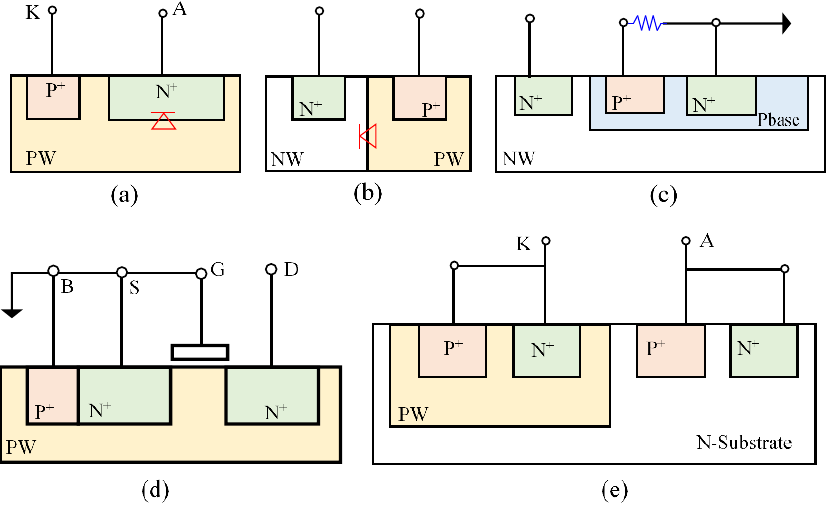
Figure 16. Traditional in-Si PN-based ESD-protection structures: ( a ) vertical diode, ( b ) lateral di- ode, ( c ) BJT, ( d ) MOSFET, and ( e ) SCR, as well as their derivatives. ( c ) BJT, ( d ) MOSFET, and ( e ) SCR, as well as their